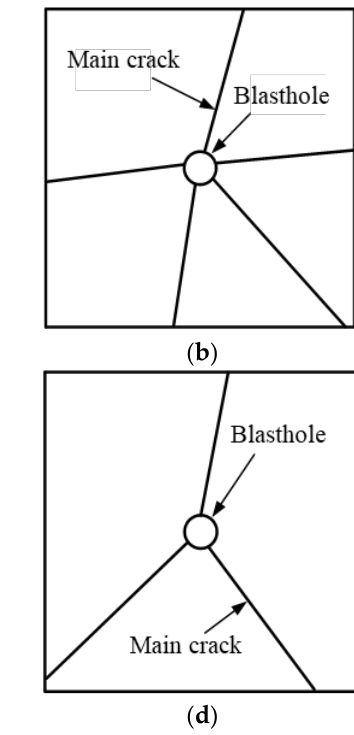
Figure 8. Shape of the main fracture and its distribution in Group A specimens. ( a ) Crack distribution of A-1 specimen; ( b ) Crack distribution of A-2 specimen; ( c ) Crack distribution of A-3 specimen; ( d ) Crack distribution of A-4 specimen Figure 9. Conical and flaky masses formed after blasting of specimen A2.